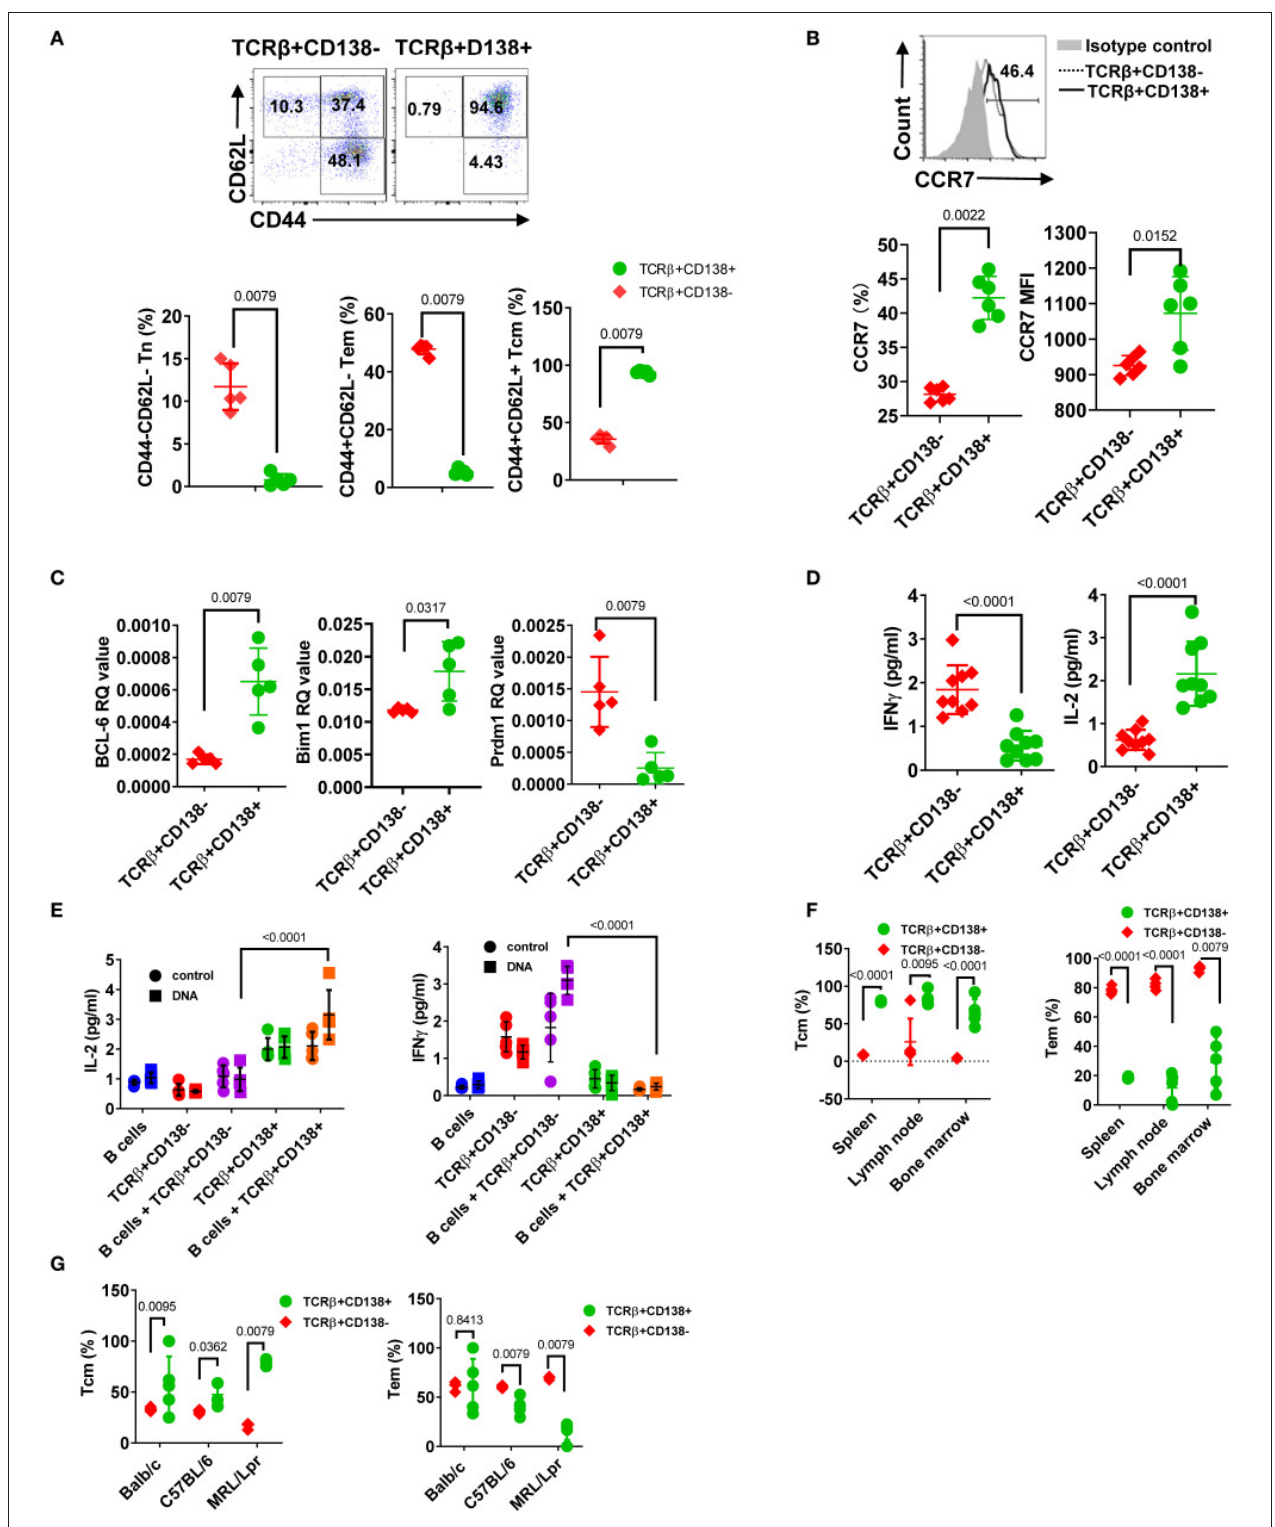
FIGURE 6 | CD138 + T cells exhibit central memory T cell phenotype. (A,B) Splenocytes were collected from 12 weeks old MRL/Lpr mice. (A) The expression of CD44 and CD62L on TCR β + CD138- and TCR β + CD138 + cells were measured by flow cytometry. Representative pseudocolor plots are shown. Mean